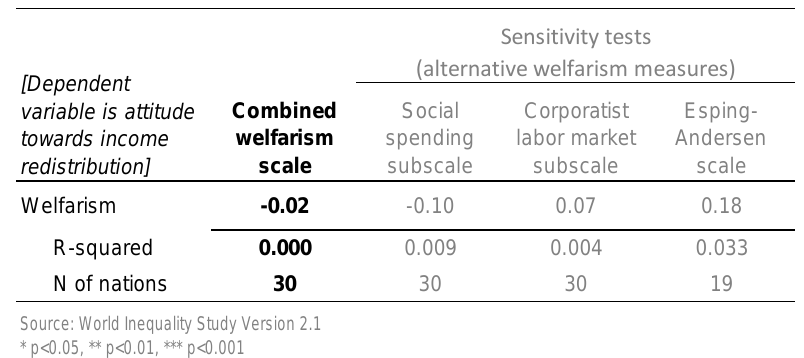
Figure 13. Welfarism and attitudes toward income redistribution. Standardized OLS regression coefficients. Aggregate data for 30 nations, 1987–2009.